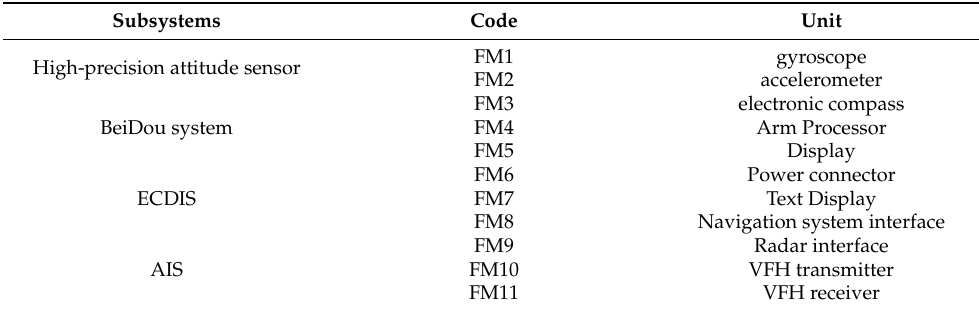
Table 4. Analyzed units.